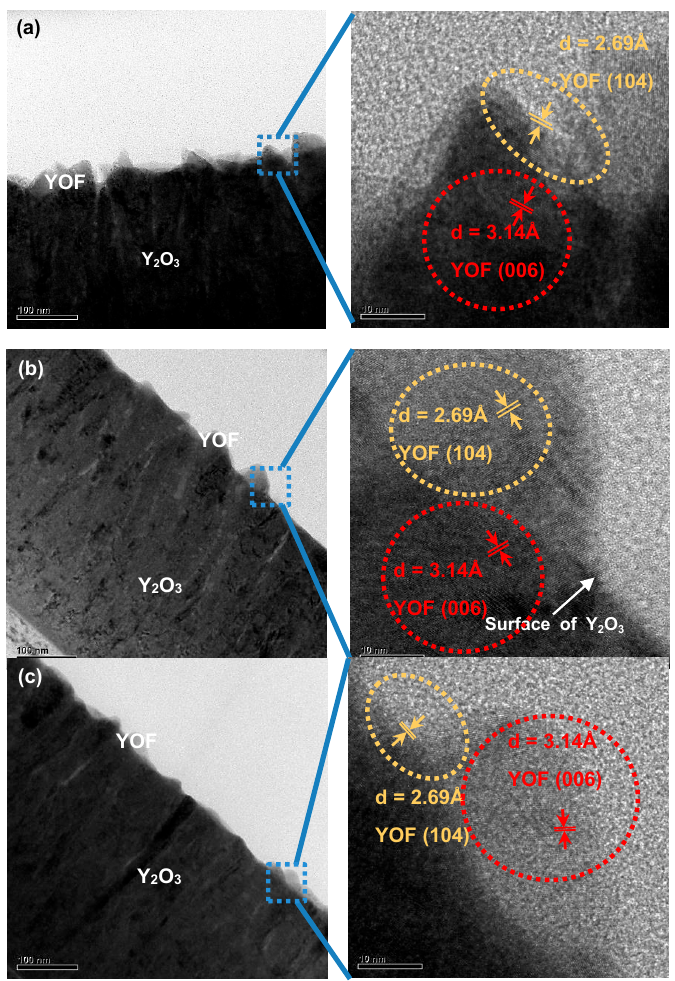
Figure 6. Cross-sectional TEM images of the plasma-treated Y 2 O 3 ( a ), and the as-deposited Y 2 O 3 and SF 6 plasma-treated Y 2 O 3 before ( b ) and after ( c ) CF 4 /O 2 plasma exposure. Right panels are magnified images of the areas enclosed by the blue squares in the left panels.